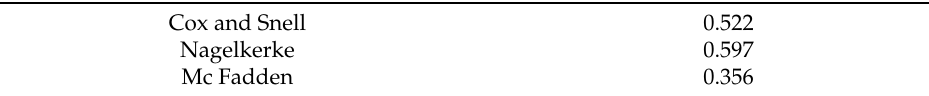
Table 7. Pseudo R-squared